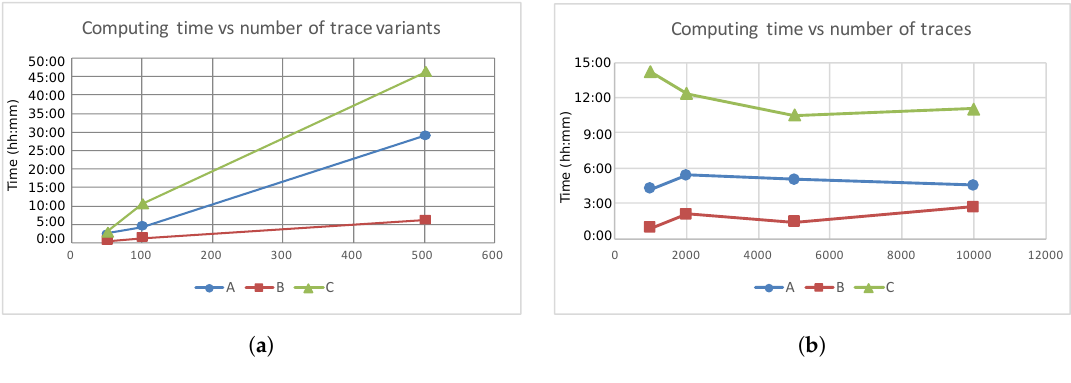
Figure 16. Performance of the exhaustive strategy when varying log complexity. ( a ) Trace variants’ complexity; ( b ) trace repetitions’